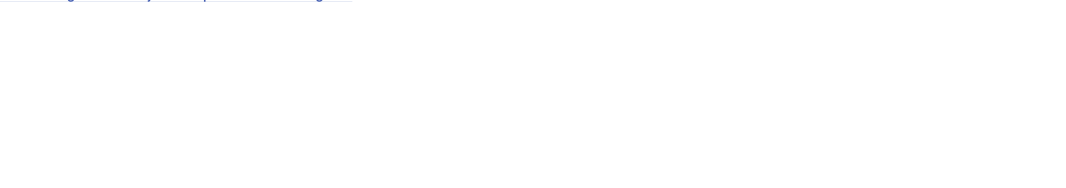
PLOS ONE | https://doi.org/10.1371/journal.pone.0254999 July 26, 2021 9 /